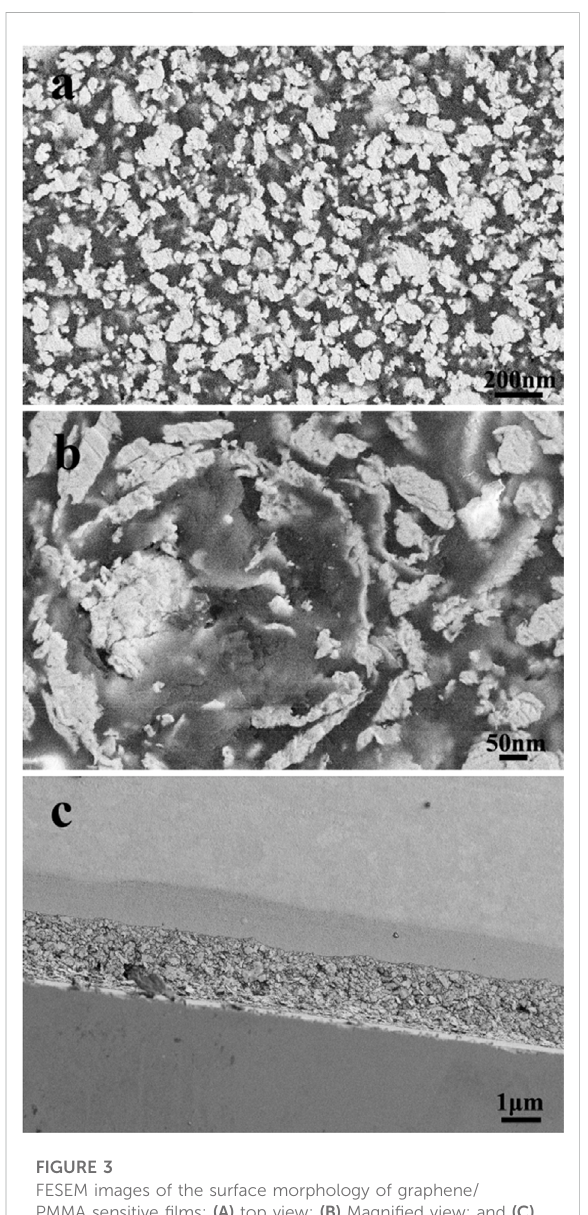
FIGURE 3 FESEM images of the surface morphology of graphene/ PMMA sensitive fi lms: (A) top view; (B) Magni fi ed view; and (C) sideways view.